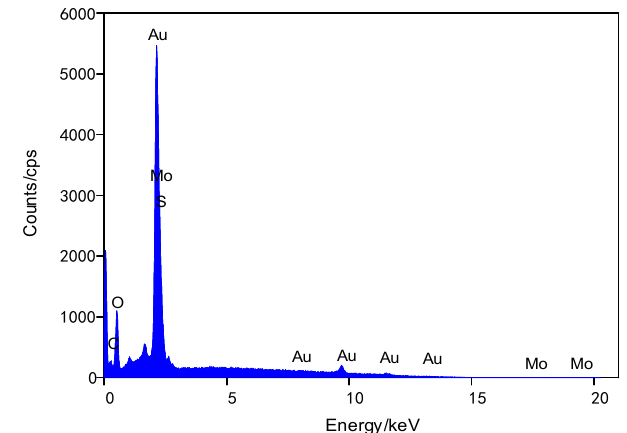
Figure A1. Energy-dispersive X-ray spectroscopy (EDS) image of AuNPs / MoS 2 / AuNPs-modified screen-printed electrode.